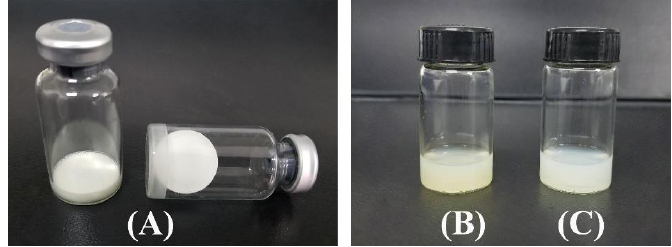
Figure 3. Appearance of lyophilized 8%-L-T, as well as the appearance of reconstituted 8%- L-T. ( A) lyophilized IPC-DNVs (8%-L-T), ( B) IPC-DNVs, ( C) reconstituted 8%-L-T. ( A ) lyophilized IPC-DNVs (8%-L-T), ( B ) IPC-DNVs, ( C ) reconstituted 8%-L-T.